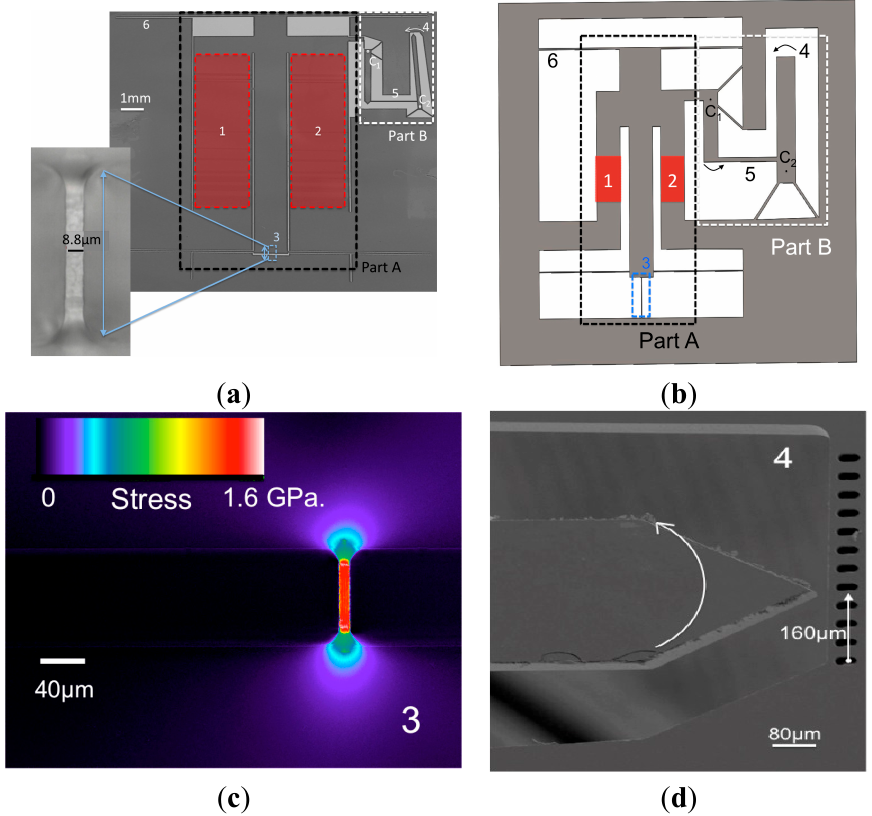
Figure 1. ( a ) Monolithic micro-tensile tester seen through an optical microscope. The overall dimensions of the system are 15 mm × 15 mm. Part A is the loading cell and part B is the displacement amplification sensor. The test beam (#3 in part A) is also shown magnified in the inset. ( b ) Graphical representation of the micro-tensile tester. Note that the dimensions of the device used here are not the real ones, but were chosen for a clearer understanding of the device’s operation. ( c ) Photoelasticity image of the test beam. ( d ) Magnified view of the system’s displaced lever beam.